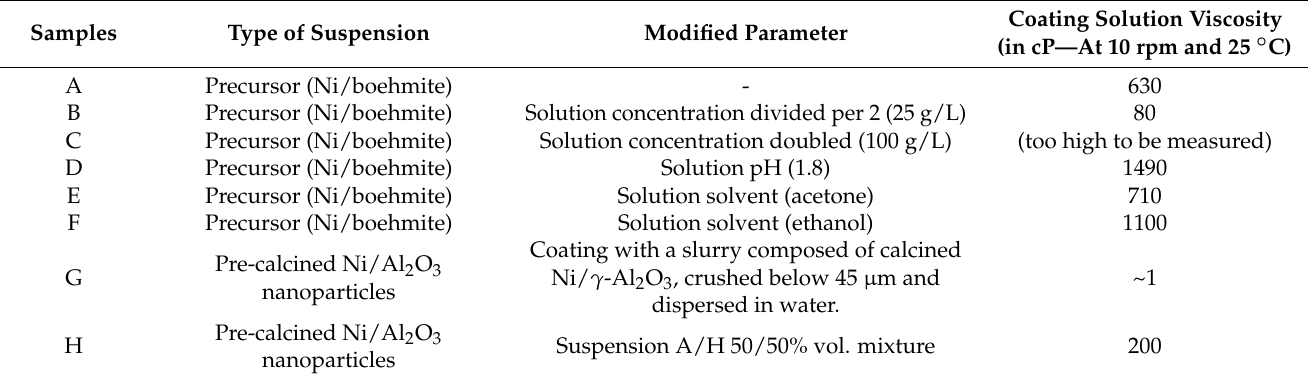
Table 1. Modifications to the coating solutions and corresponding